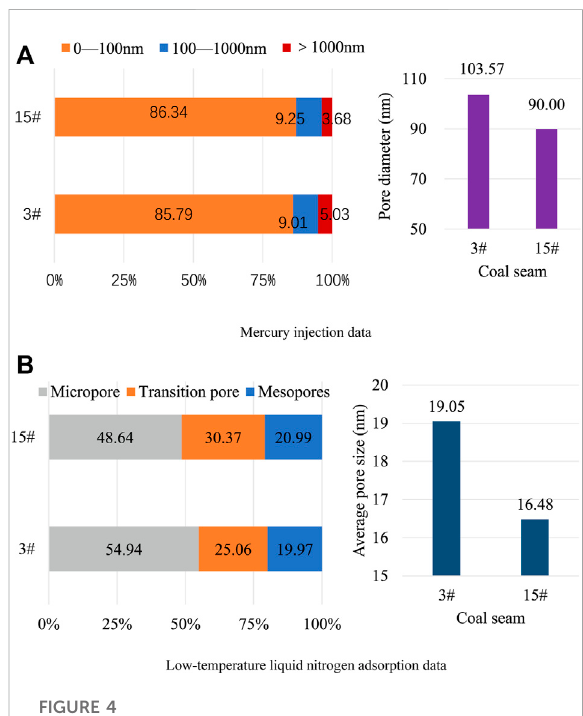
FIGURE 4 Pore characteristics of No. 3 and No. 15 coal seams (Hu et al.,